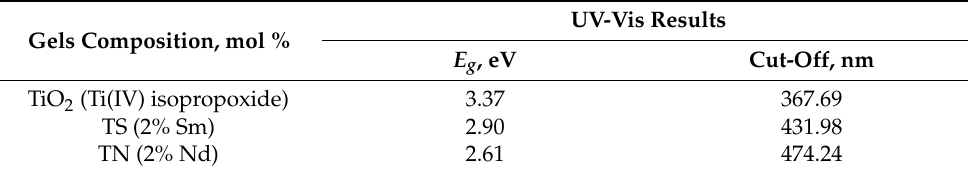
Table 1. Observed cut-off and calculated optical band gap values ( E g ) of the obtained gels. Gels Composition, mol